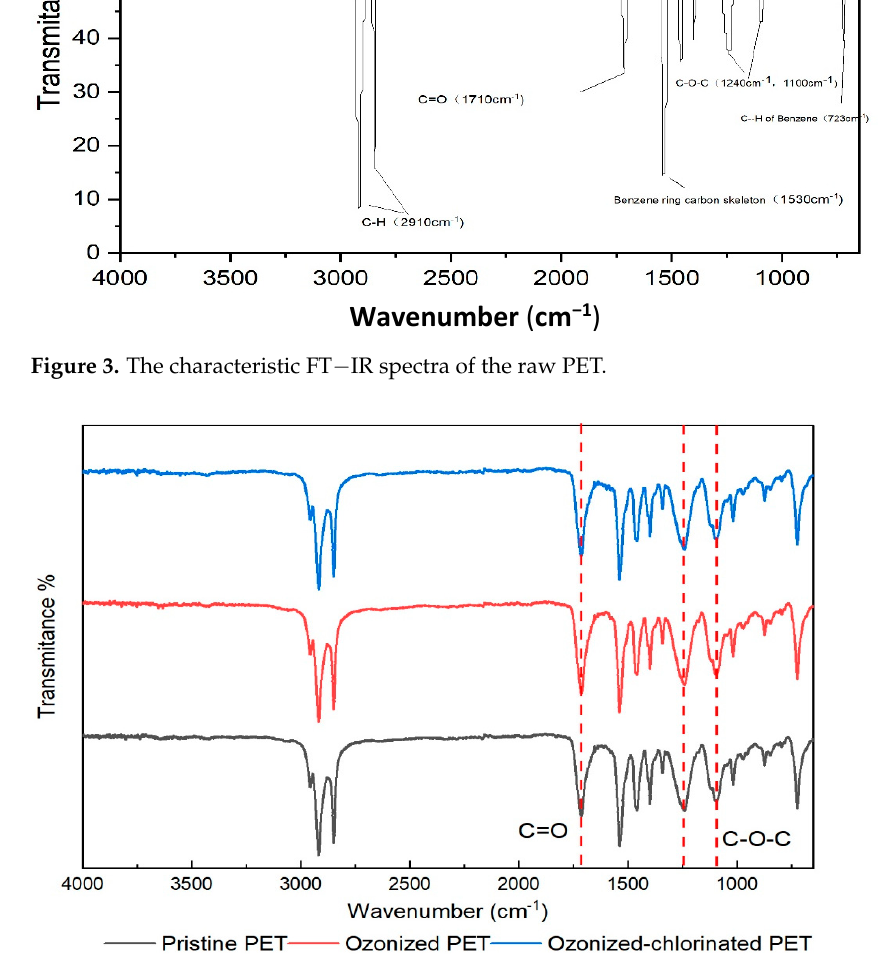
Figure 4. The FT − IR spectra of the PET with different oxidation treatments.